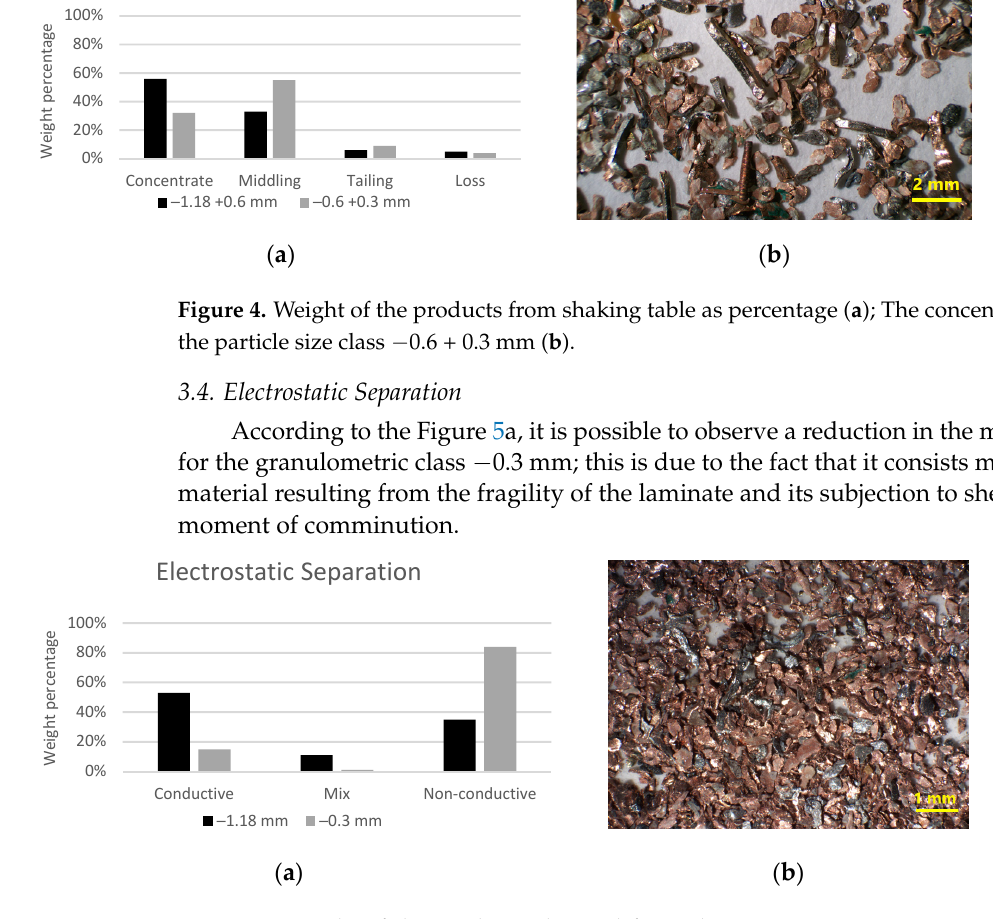
Figure 5. Weight of the products obtained from electrostatic separation as percentage ( a ); The conductive product for the particle size class − 0.3 mm ( b ) .